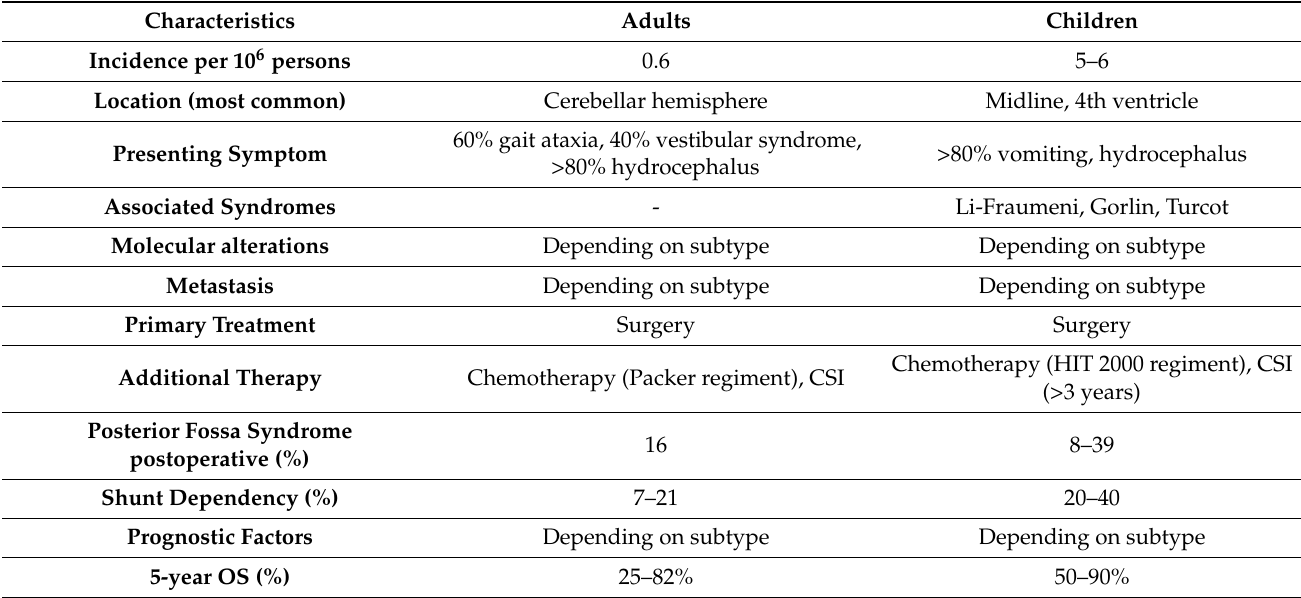
Table 2. Overall characteristics for adult and pediatric medulloblastoma based on the following references [8,11,12,27,29,33– 35,40–42,44,45] Abbreviations: CSI = craniospinal